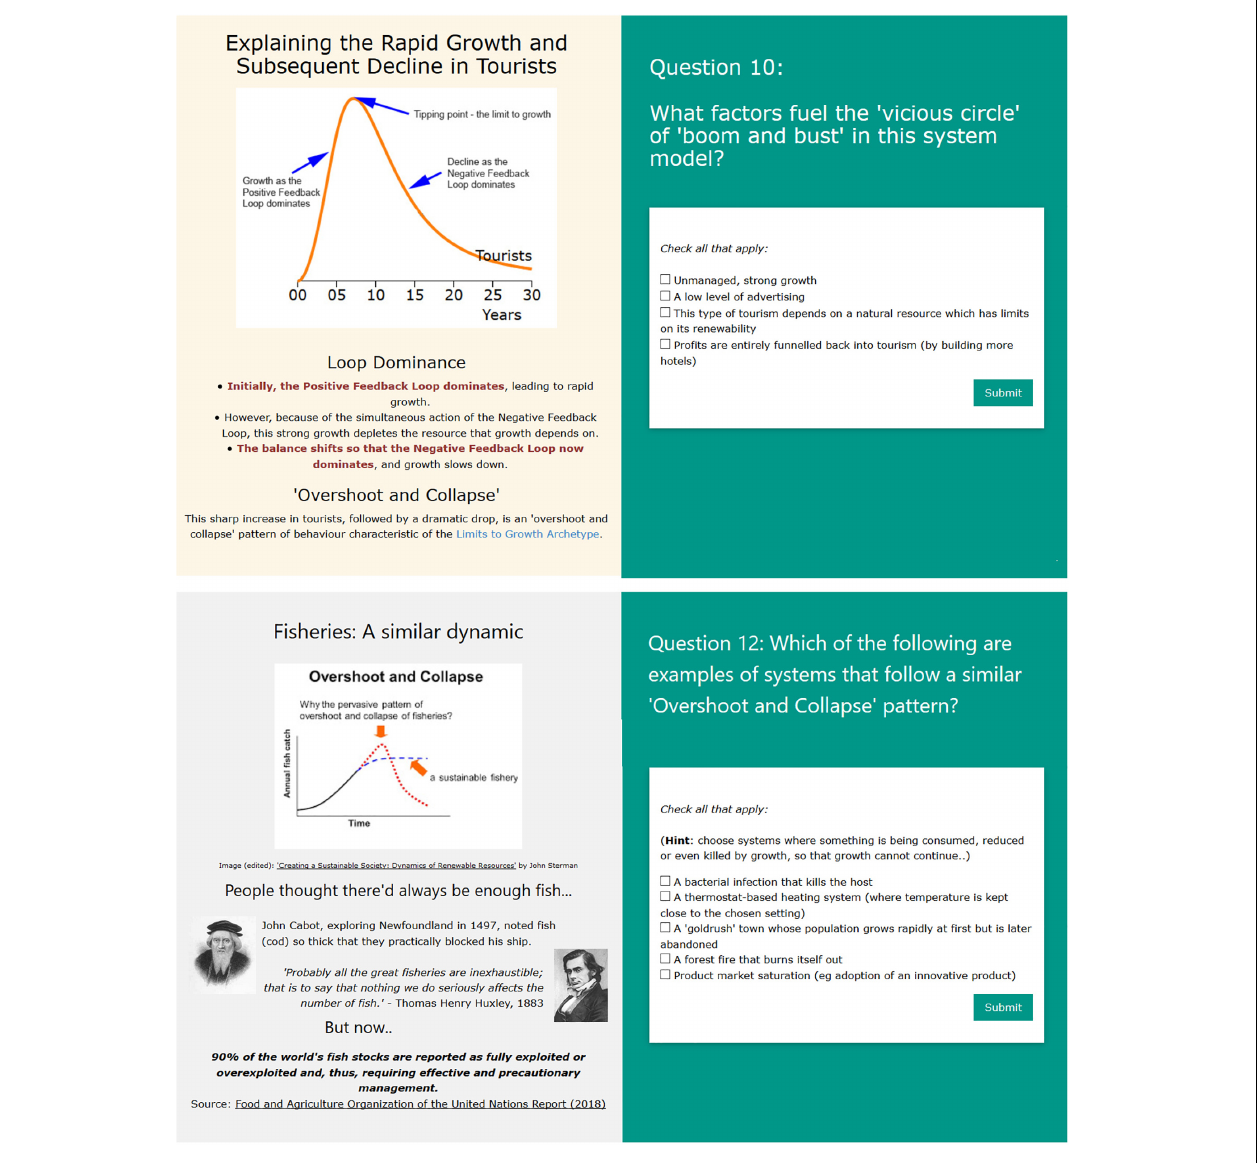
FIGURE 4 | OL tool screenshots: description of the Limits to Growth Archetype and its relevance to Coastal Tourism, together with a reinforcing in-tool quiz question; application of the same Archetype to Fisheries, and quiz question to test for recognition in other systems (RQ2).